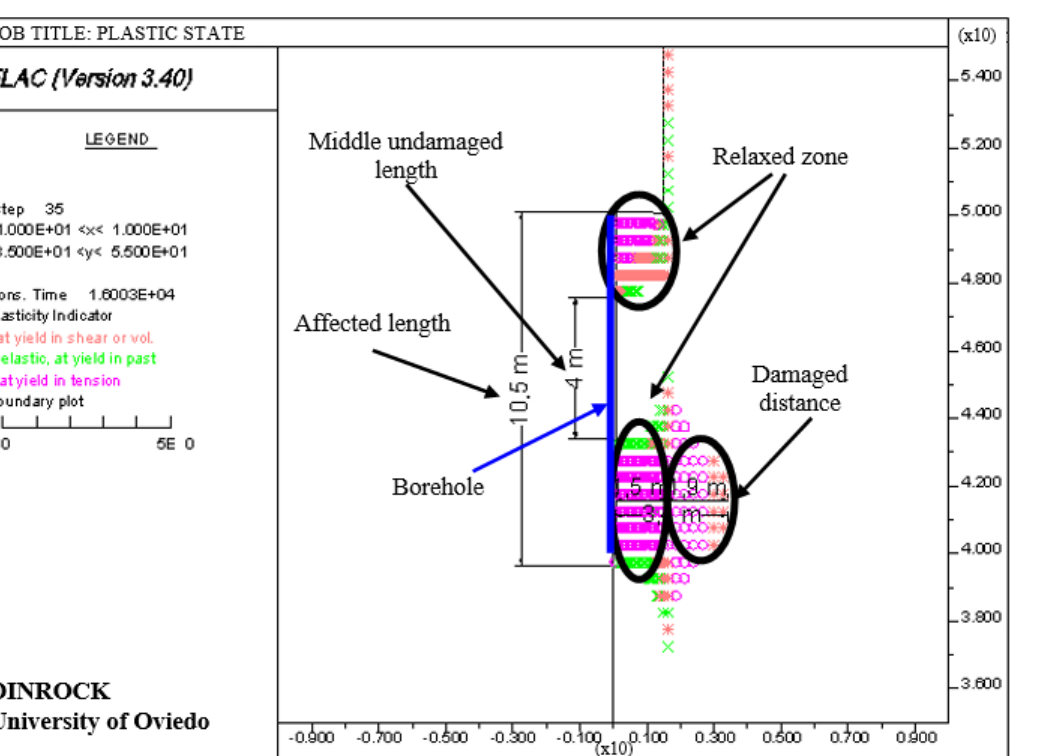
Table 4. Parameter variation in the calculated models.